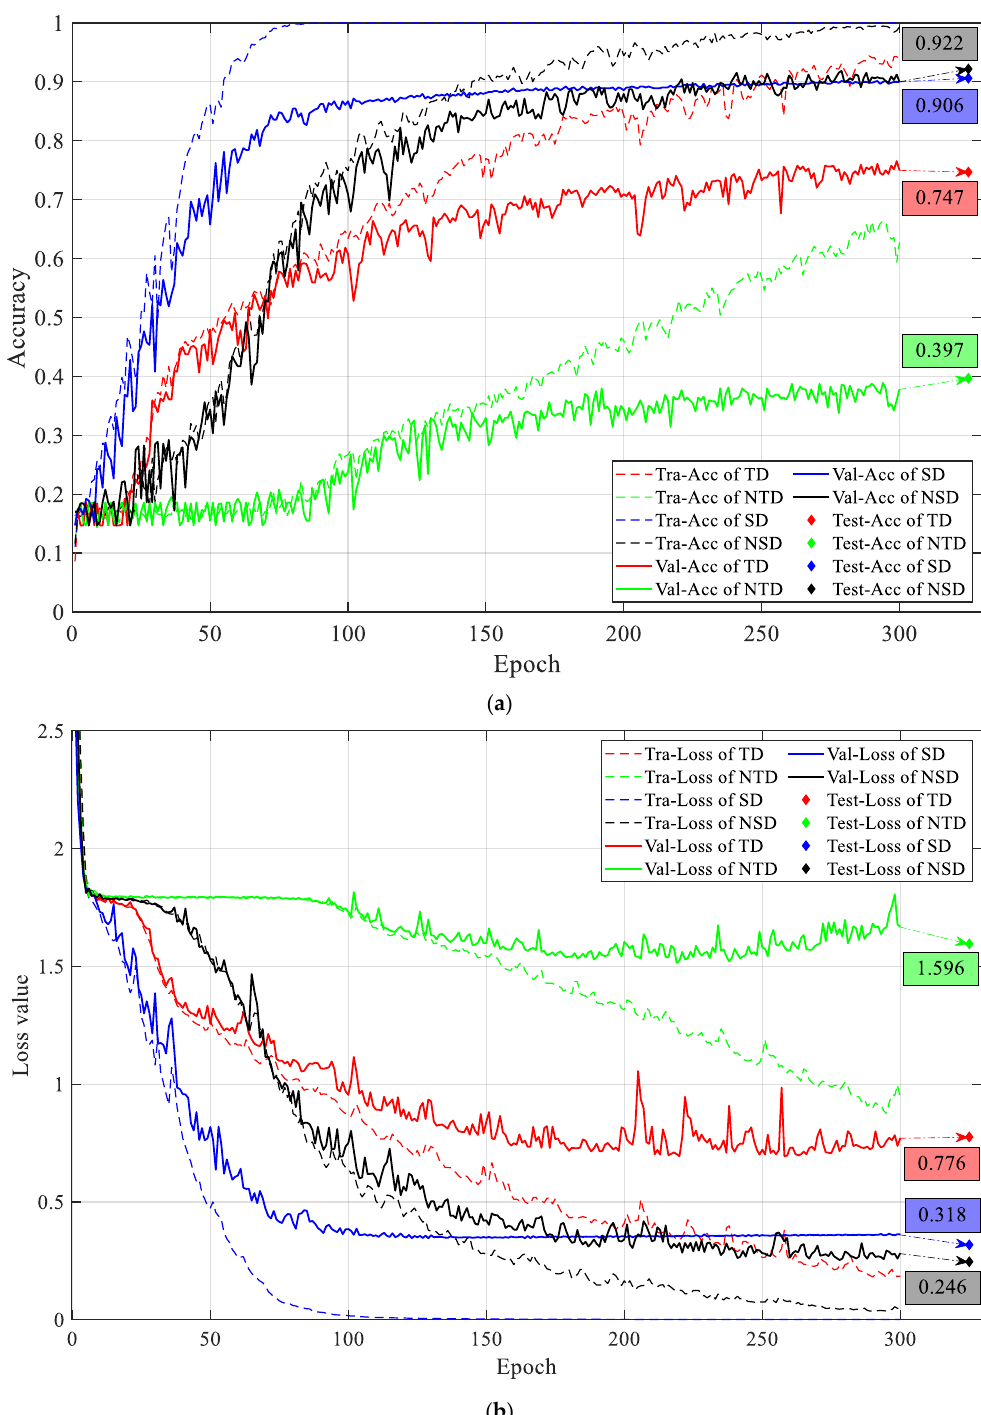
Figure 17. Performance comparison of time domain and frequency domain in terms of accuracy ( a ) and the loss value ( b